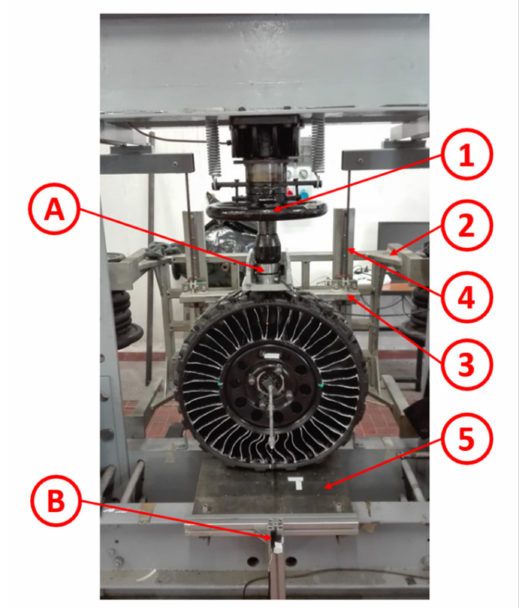
Figure 2. Test rig components and measurement instruments: (1) manually actuated hydraulic press, (2) fixed frame, (3) vertically mobile frame, (4) linear guide rails, (5) fixed plate, (A) load cell, (B) draw-wire sensor.